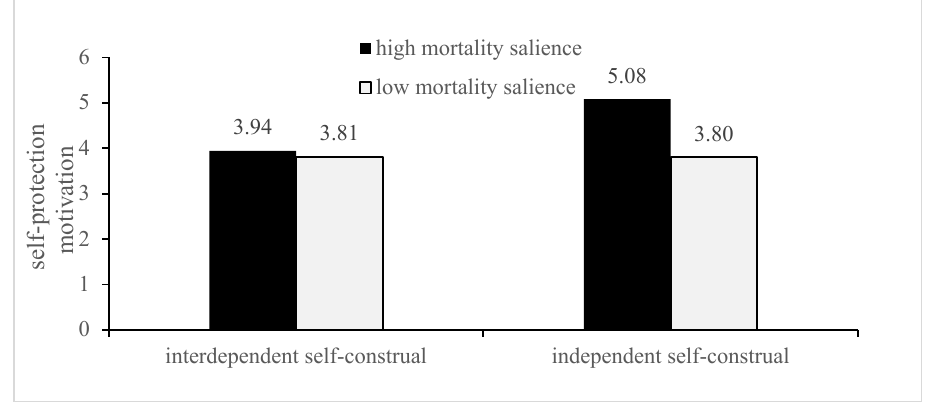
Figure 4. Moderating effect of self-construal type on the effect of mortality salience on self-protection motivation.